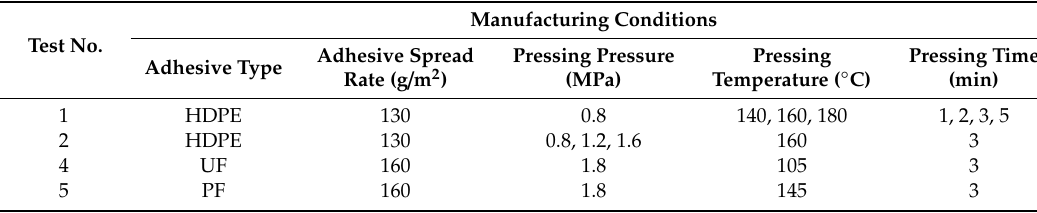
Table 1. Manufacturing conditions of plywood.